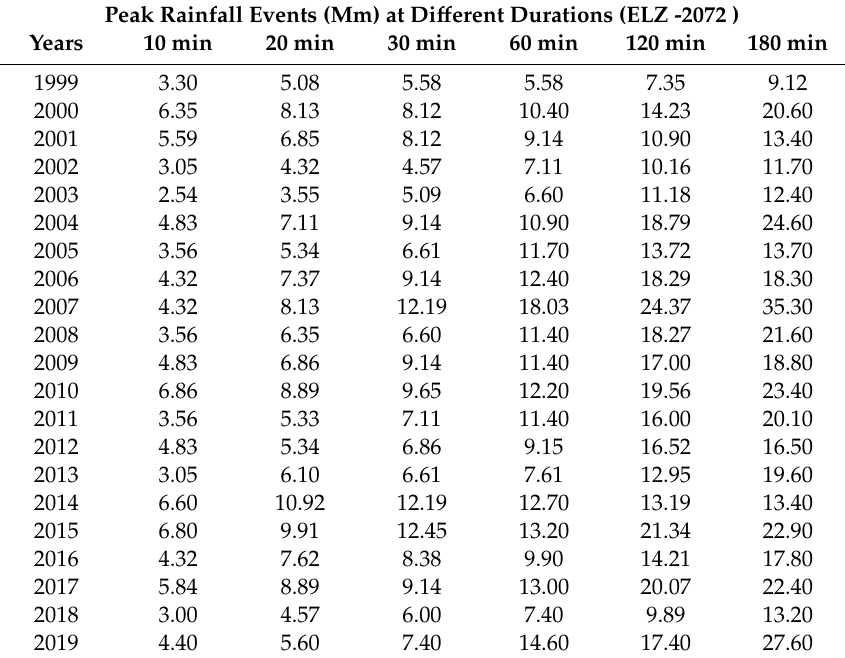
Table 2. Peak rainfall events for ELZ station (2072).